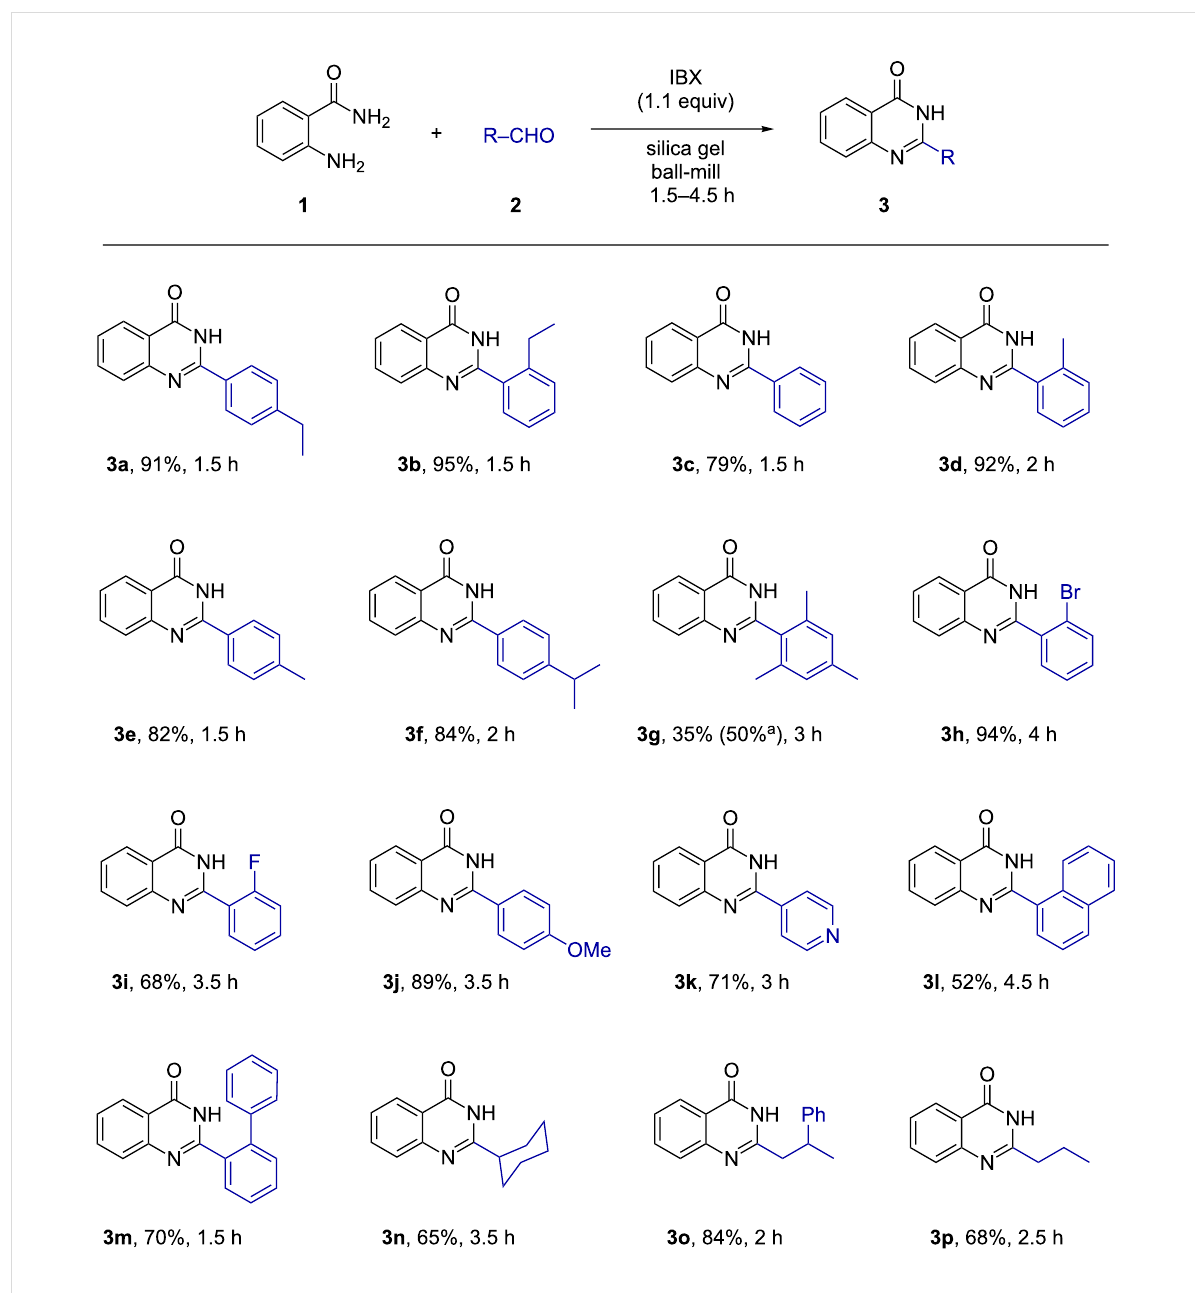
Figure 3: Synthesis of quinazolin-4(3 H )-one derivatives from the reaction of 1 with liquid aldehydes. a Yields with respect to recovered aldehydes, for compound 3k IBX was added after 1